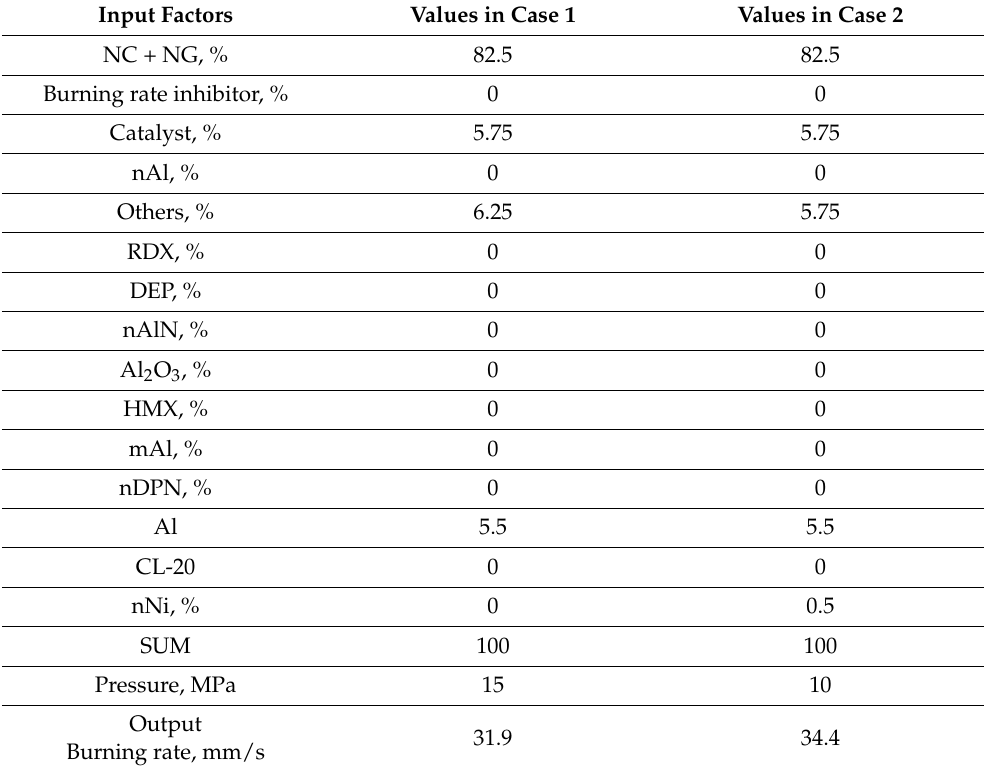
Table 1. Examples of results of calculation of the ANN MCM that solves the direct